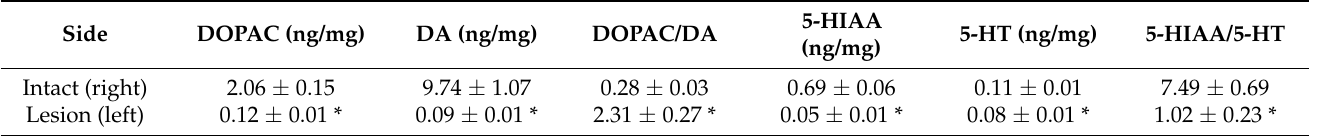
Table 1. High Performance Liquid